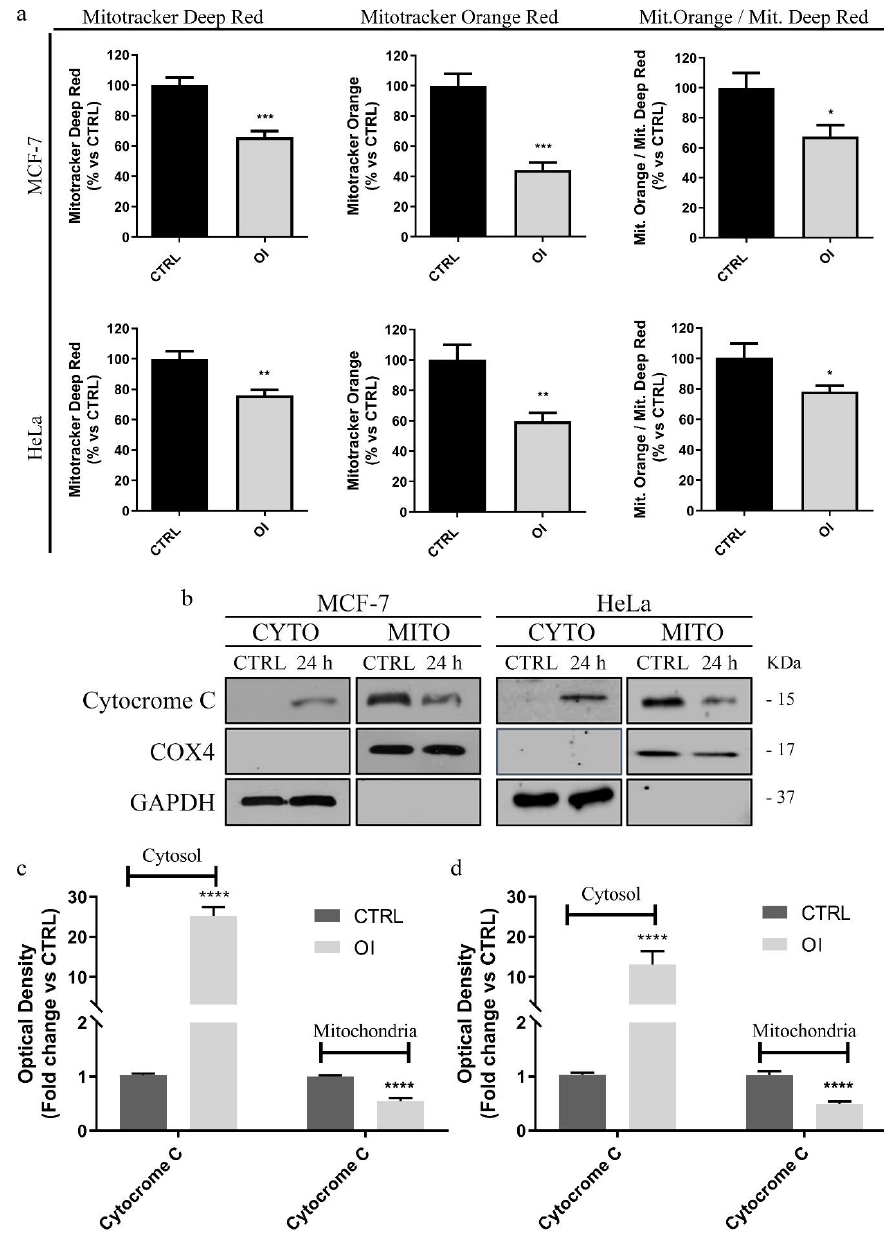
Figure 4. OI treatment induces mitochondrial damage in cancer cells. ( a ) Both MCF-7 and HeLa cells were treated for 24 h either with DMSO (CTLR) or 15 and 30 µ M OI , respectively, then they were stained with different metabolic probes and analyzed by FACS. Note that the treatment decreases mitochondrial mass (MitoTracker Deep-Red) and mitochondrial membrane potential (MitoTracker Orange). Assessment of mitochondrial membrane potential vs. mitochondrial mass displayed that OI decreases mitochondrial membrane potential per mitochondria. Immunoblot and densitometric analysis of cytochrome c in treated MCF-7 ( b , c ) and HeLa ( b , d ) cells. GAPDH was used as a loading control of cytosolic fractions, whereas COX4 of the mitochondrial one. A significant release of cytochrome c into the cytosol is revealed in both tested cancer cell lines. Histograms represent means ± SD of three independent experiments in which band intensities were assessed as optical density arbitrary units (OD) and expressed as fold change vs. control samples (CTRL). **** p value < 0.0001.